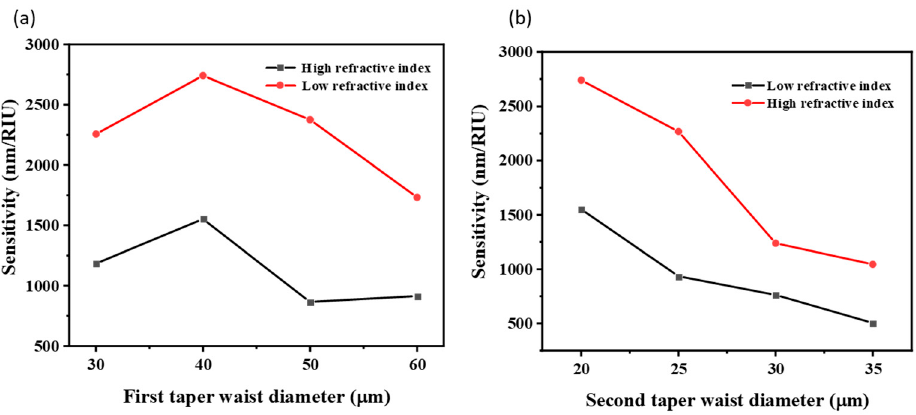
Figure 3. The influence of ( a ) the first taper waist diameter and ( b ) the second waist diameter on sensitivity performance of the taper-in-taper fiber sensor. Table 2. Tapered fiber sensors with different second taper ratios.